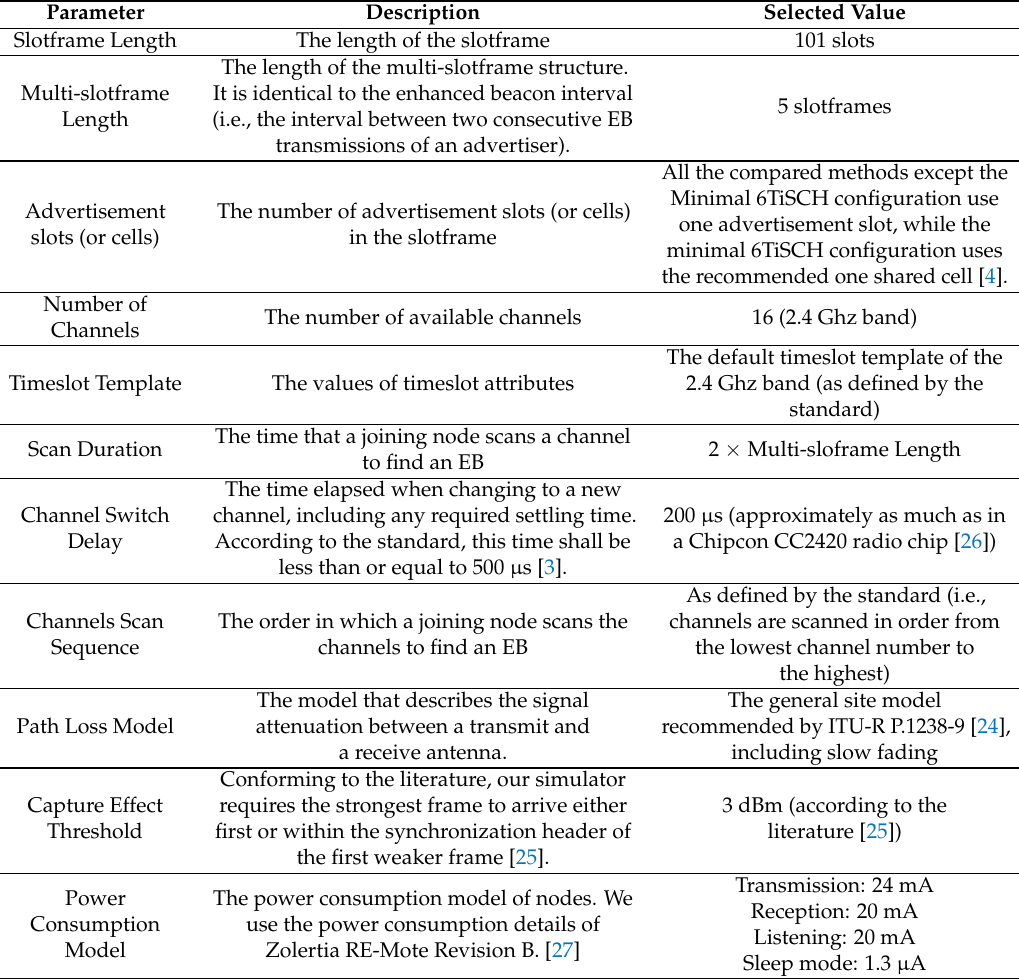
Table 2. General simulations parameters.